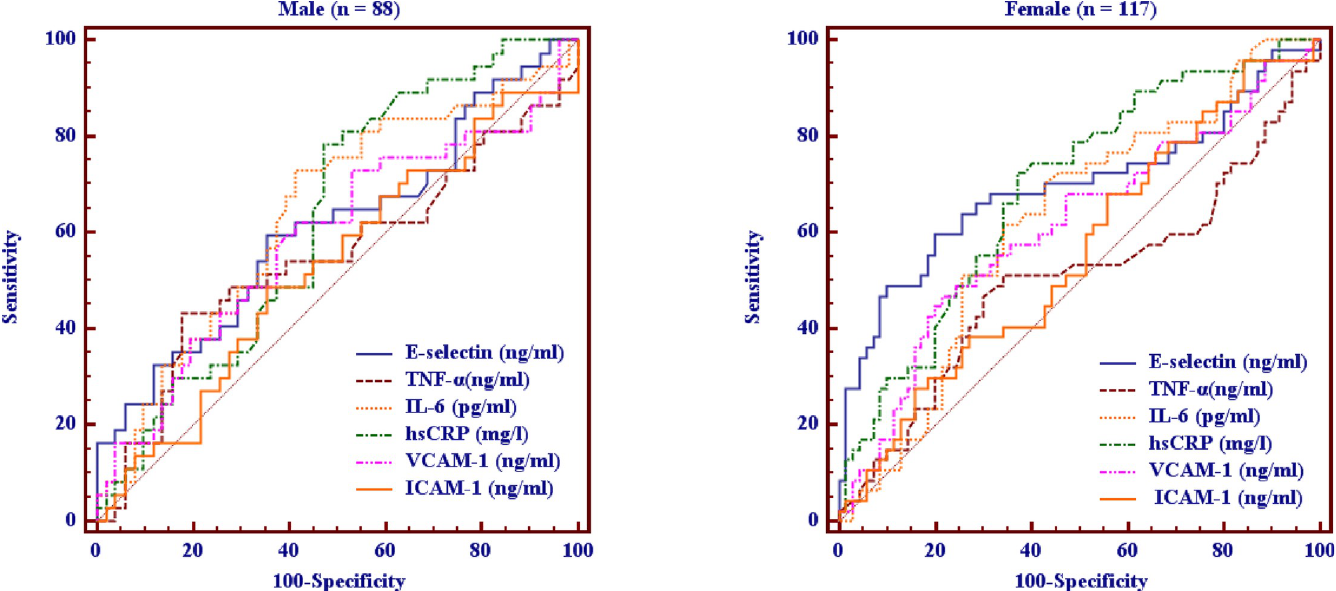
Fig 2. ROC curve analysis of values for inflammatory markers (TNF- α , IL-6, hsCRP) and endothelial dysfunction markers (E-selectin, ICAM-1, VCAM-1) in the detection of MetS status, as shown by gender.